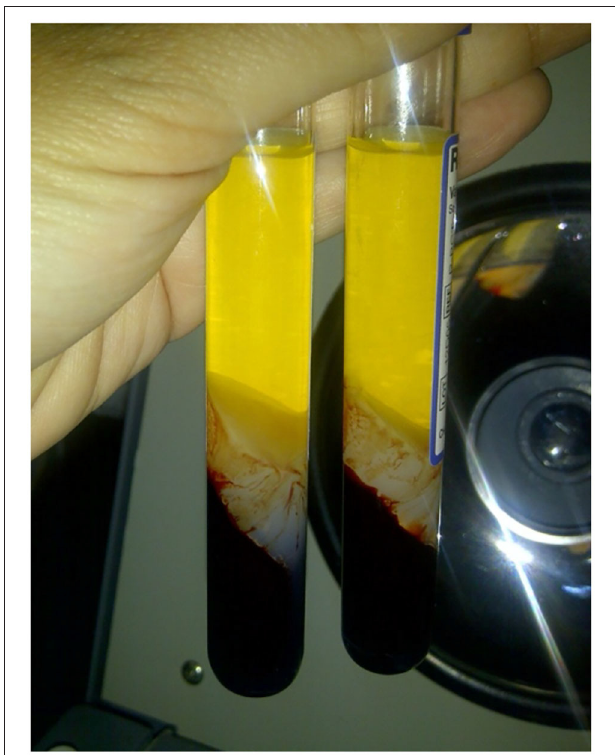
FIGURE 5 | RegenKit tube with separator gel in the middle. Platelet might be trapped in the gel tube thus resulting in lower platelet count in the resulting